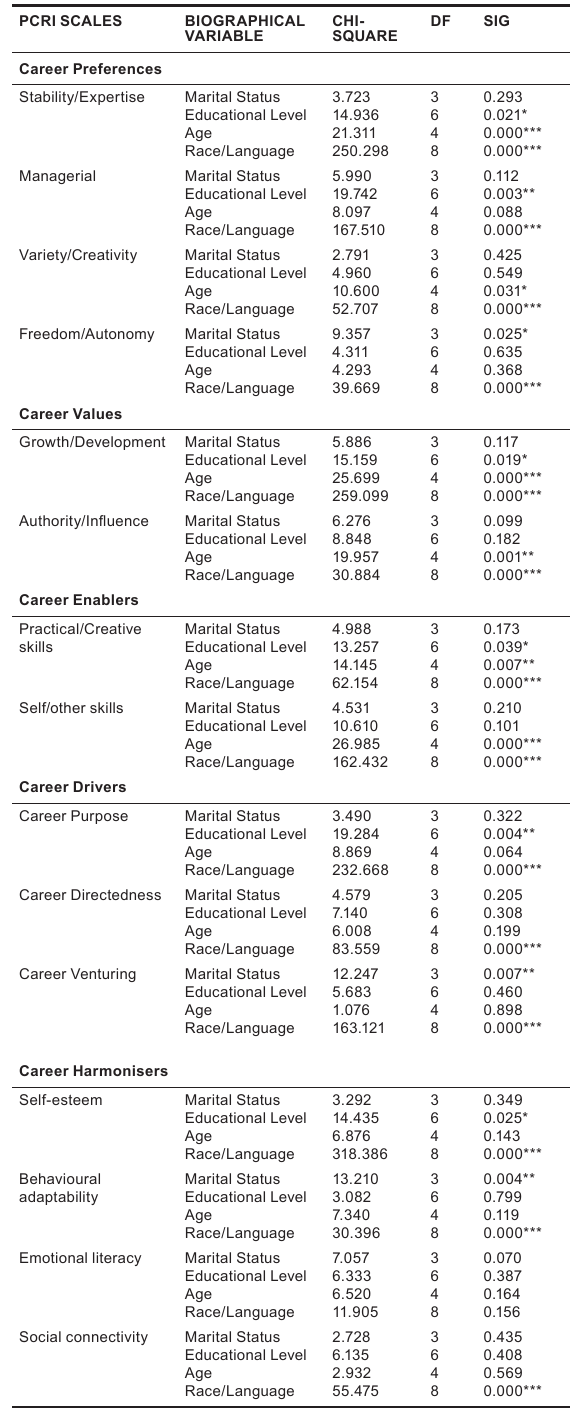
Table 3 Mann-Whitney U-test for gender (N = 2 997)